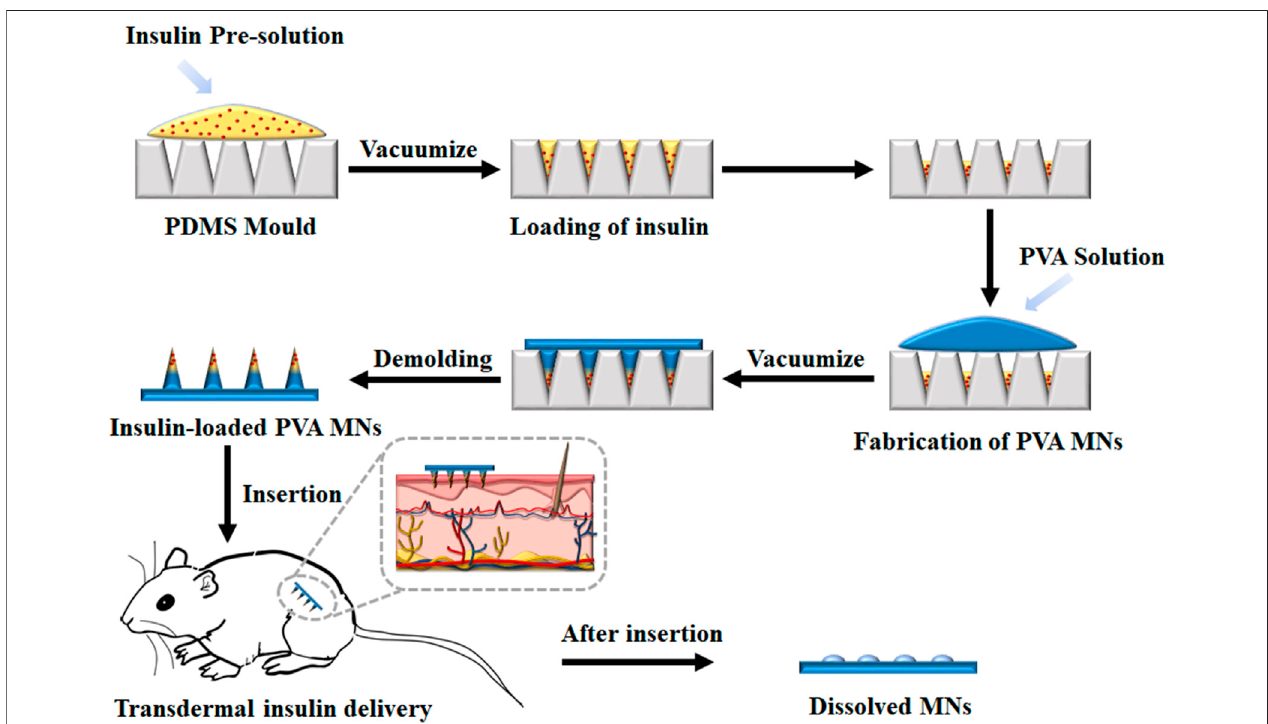
FIGURE 1 | Schematic illustrations of insulin-loaded MNs patch fabrication process and its application.